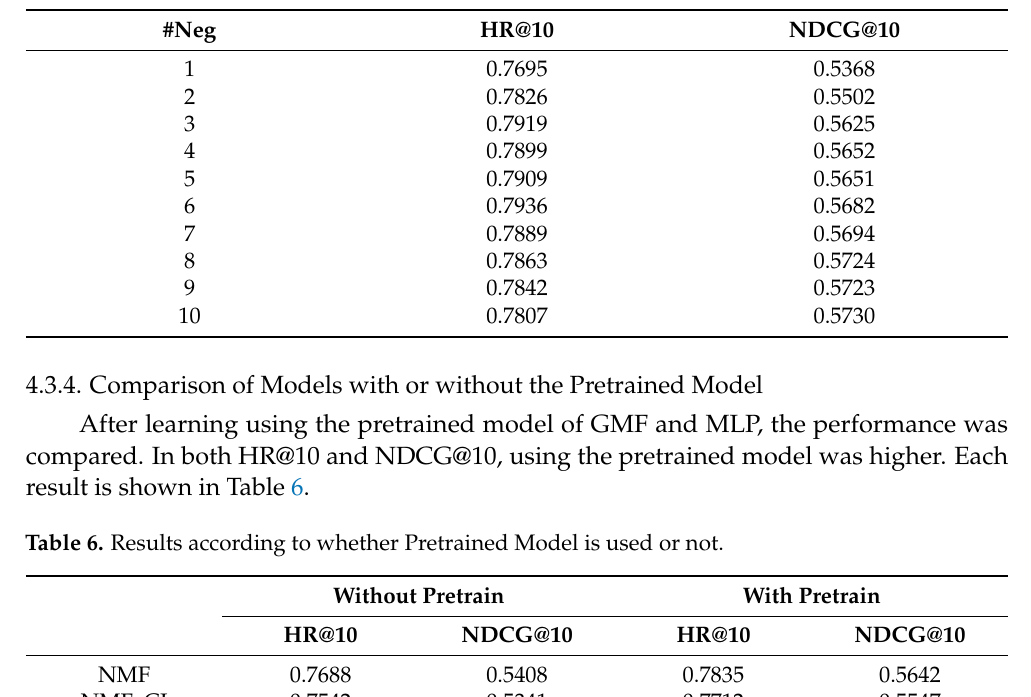
Table 5. Results according to the number of negative samples.